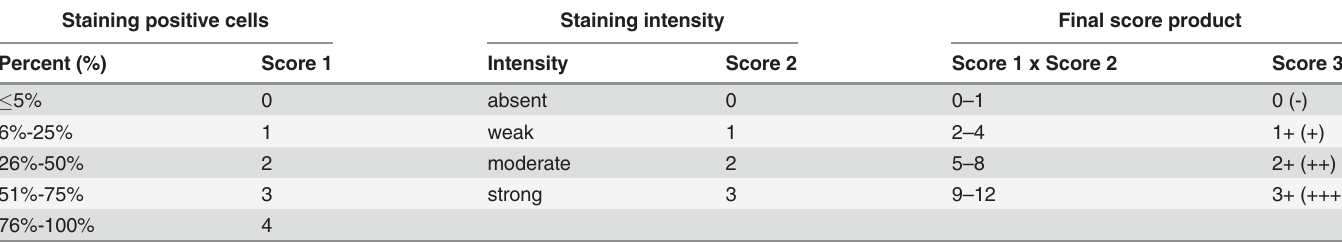
Table 1. Scoring criteria of Immunohistochemistry (IHC) assay with speci fi c antibodies used in this study. Staining positive